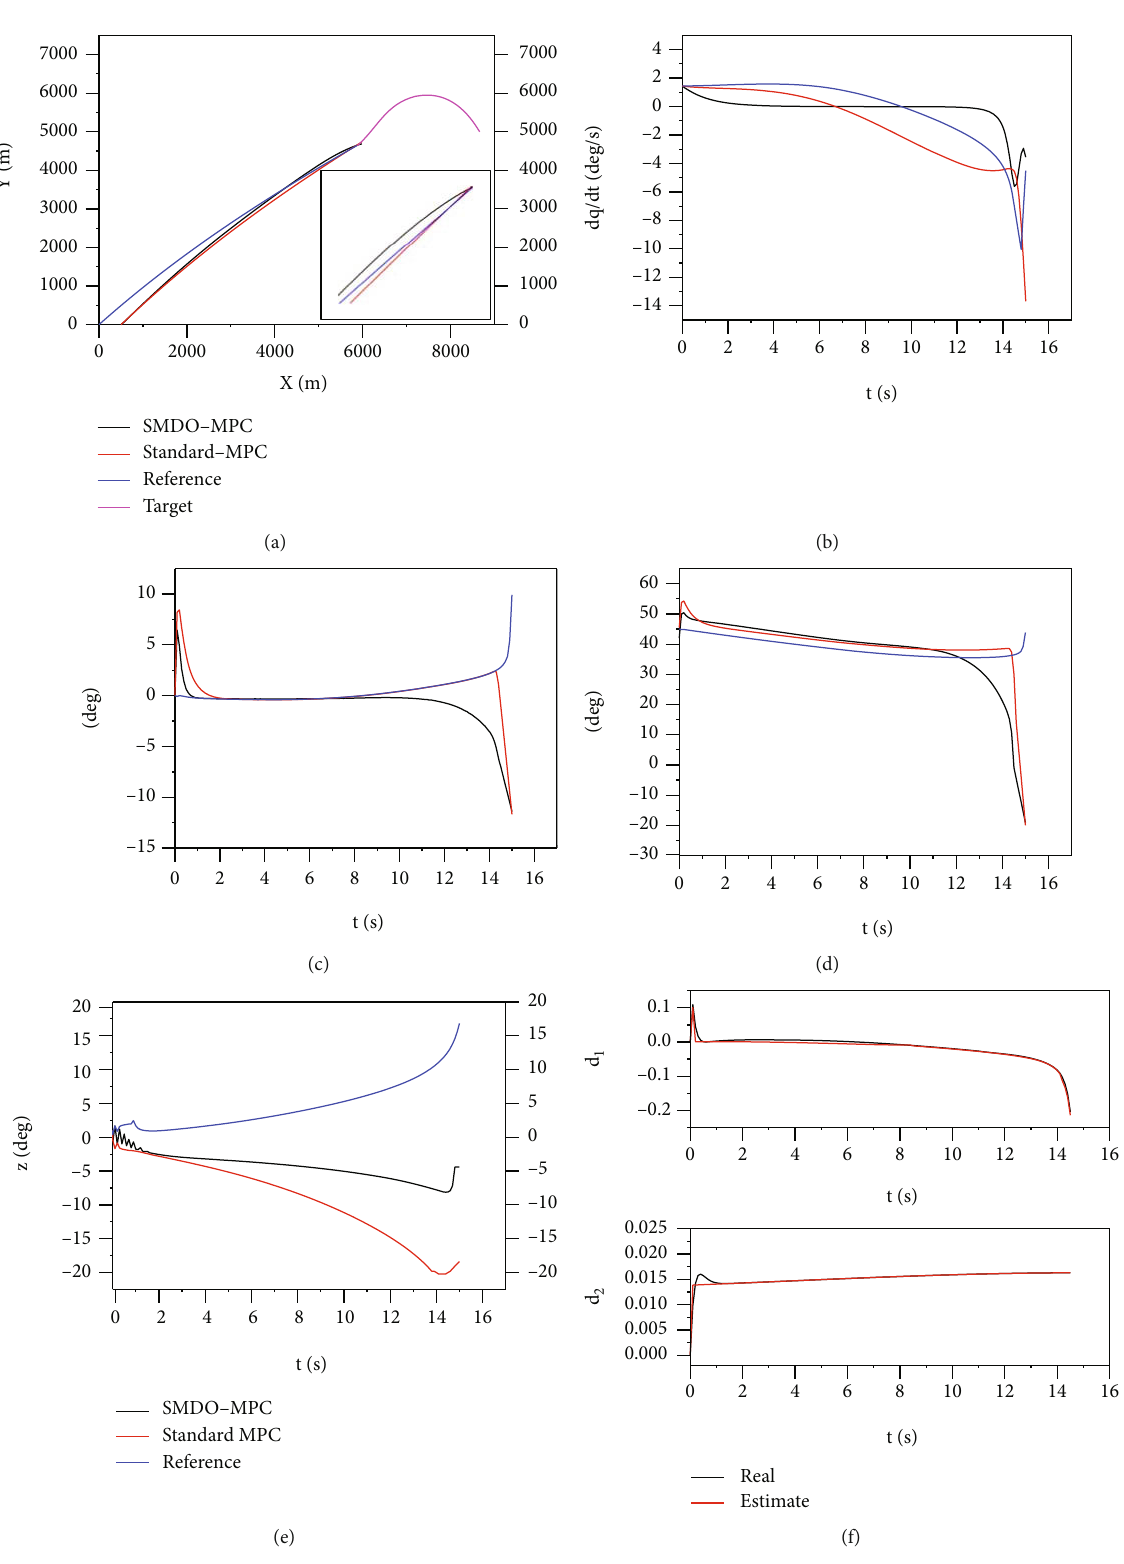
Figure 5: Simulation results under Case 1: (a) intercept trajectory, (b) the LOS angular rate, (c) the attack angle, (d) the pitch angle, (e) the de fl ection angle, and (f) real value and estimate value of